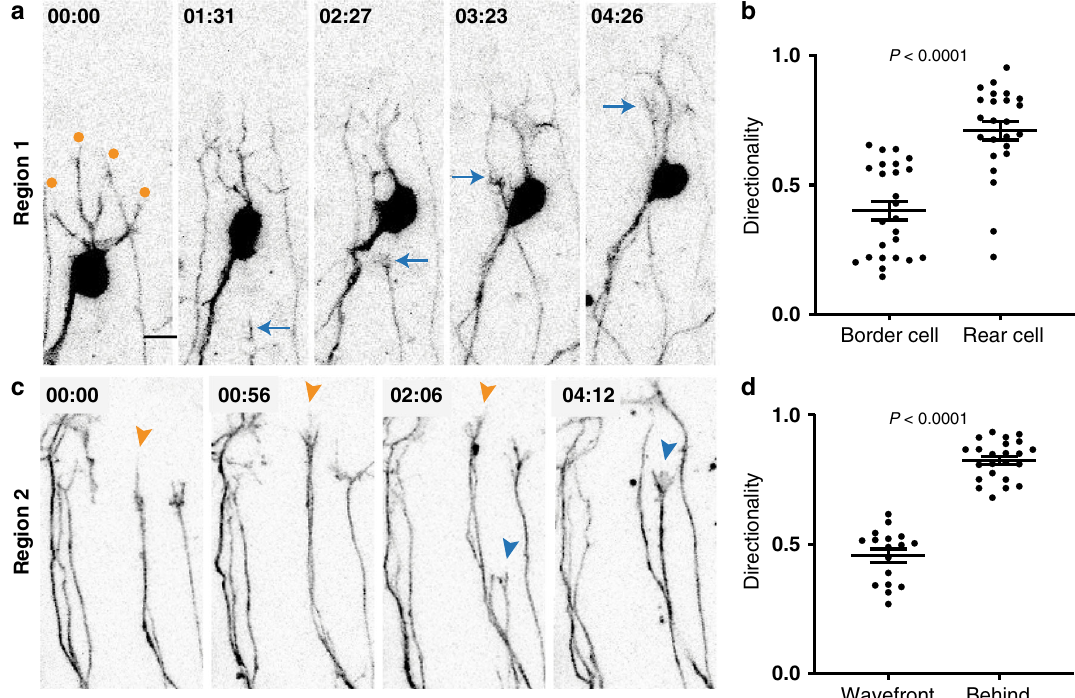
0.0 Wavefront Behind Fig. 4 Directionality differs among SGN processes growing through similar regions. a – d Frames from movies of sparsely labeled tdTomato + SGNs from Neurog1 CreERT2 ;Ai14 animals as they grow in Region 1 ( a ) ( N = 3 cochleae) (Supp. Movie 5) or Region 2 ( c ) ( N = 3 cochleae) (Supp. Movie 6), with directionality quanti fi ed in ( b ) and ( d ). In Region 1 ( a ), a border SGN extends highly branched processes (orange dots) whereas a peripheral process from a rear cell (cell body out of view) (blue arrows) follows a rapid and directed path. Quanti fi cation of 25 border and 24 rear cells ( b ) con fi rmed that peripheral processes from rear cells are signi fi cantly more directed. In Region 2 ( c ), an SGN process at the wavefront (orange arrowheads) extends many branches and makes little progress. An SGN process arriving from behind (blue arrowheads) moves rapidly and is capped by a large, unbranched growth cone. Quanti fi cation ( d ) revealed signi fi cantly more directed growth of processes behind the wavefront ( n = 17 wavefront processes and 23 trailing processes). Note that not all SGN processes are labeled, so it is not possible to detect fasciculation events reliably. Raw data are plotted, with mean ± SEM superimposed. Signi fi cance was assessed using an unpaired, two-tailed t -test. Directionality: border vs rear, P < 0.0001; wavefront vs behind, P < 0.0001. Source data are provided as a Source data fi le. Time is indicated in hh:mm. Scale bar = 10 µ m ( a , c